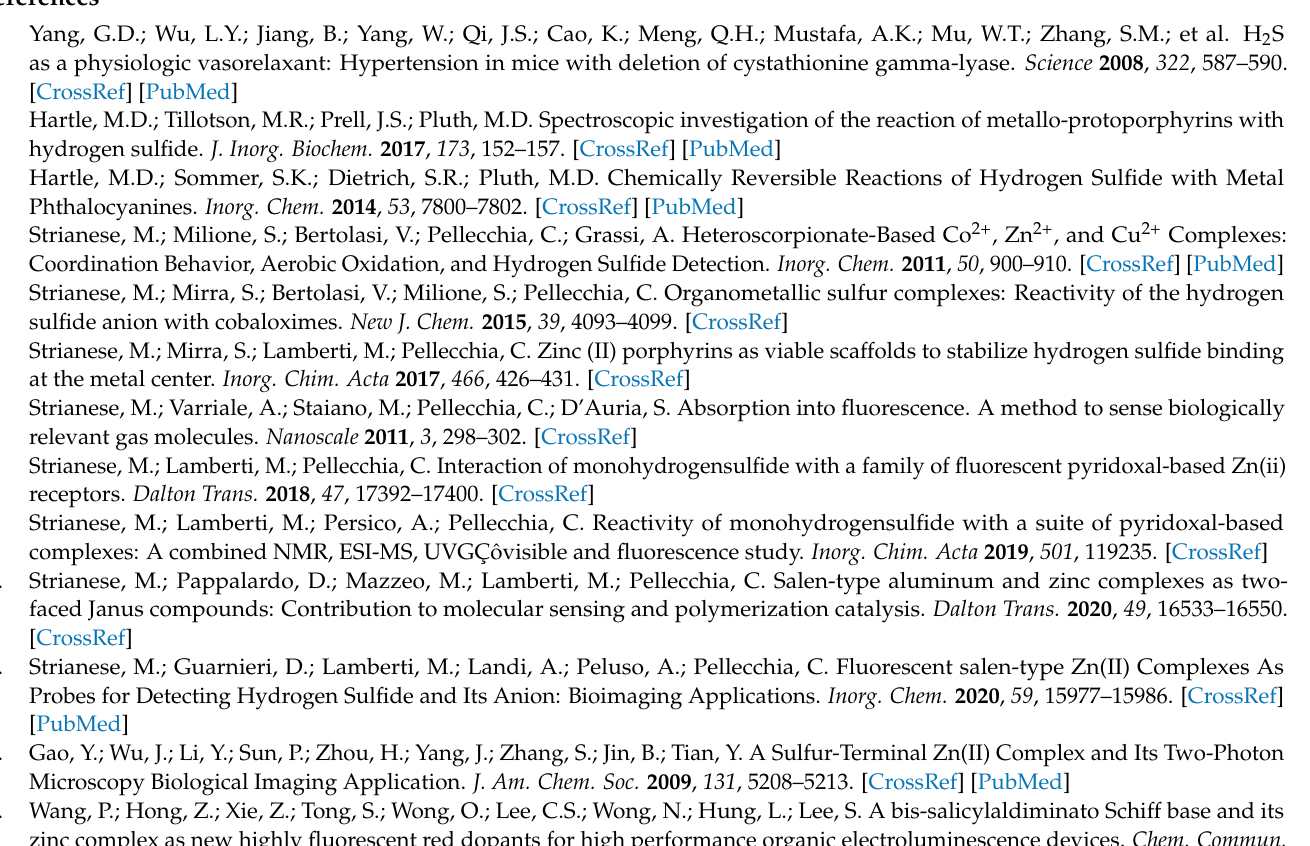
4 in DMSO- d 6 . Figure S11. 1 H NMR spectrum of complex 5 in DMSO- d 6 . Figure S12. 13 C NMR spectrum of complex 1 in DMSO- d 6 . Figure S13. 13 C NMR spectrum of complex 3 in DMSO- d 6 . Figure S14. 13 C NMR spectrum of complex 4 in DMSO- d 6 . Figure S15, 13 C NMR spectrum of complex 5 in DMSO- d 6 . Figure S16. 1 H NMR spectrum of complex 1 in DMSO- d 6 upon addition of NaHS. Figure S17. 1 H NMR spectrum of complex 2 in DMSO- d 6 upon addition of NaHS. Figure S18. 1 H NMR spectrum of complex 3 in DMSO- d 6 upon addition of NaHS. Figure S19, 1 H NMR spectrum of complex 4 in DMSO- d 6 upon addition of NaHS. Figure S20. 1 H NMR spectrum of complex 5 in DMSO- d 6 upon addition of NaHS. Figure S21 . Optimized geometry for complex 5 and its adduct with HS − . Figure S22. Images of solutions of complex 5 before and after treatment with HS − . Figure S23. Fluorescence intensity time trace of complex 5 . Figure S24. Emission spectra of complex 5 . Figure S25. Original non-cropped images of complex 5 -loaded paper strips after adding increasing amounts of HS − dissolved in cell culture medium and cell-conditioned media. Table S1. Photophysical features of complexes 1 and 5